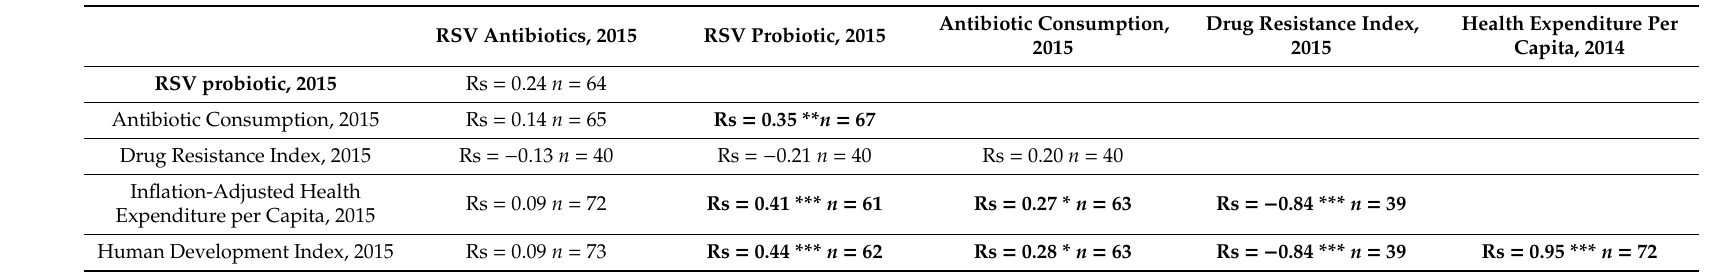
Table 2. R Spearman rank-correlation